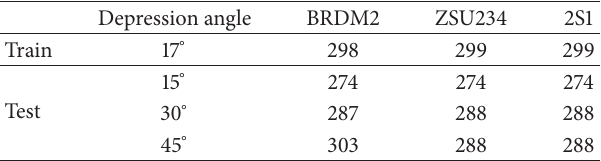
Table 3: Variant depression angle